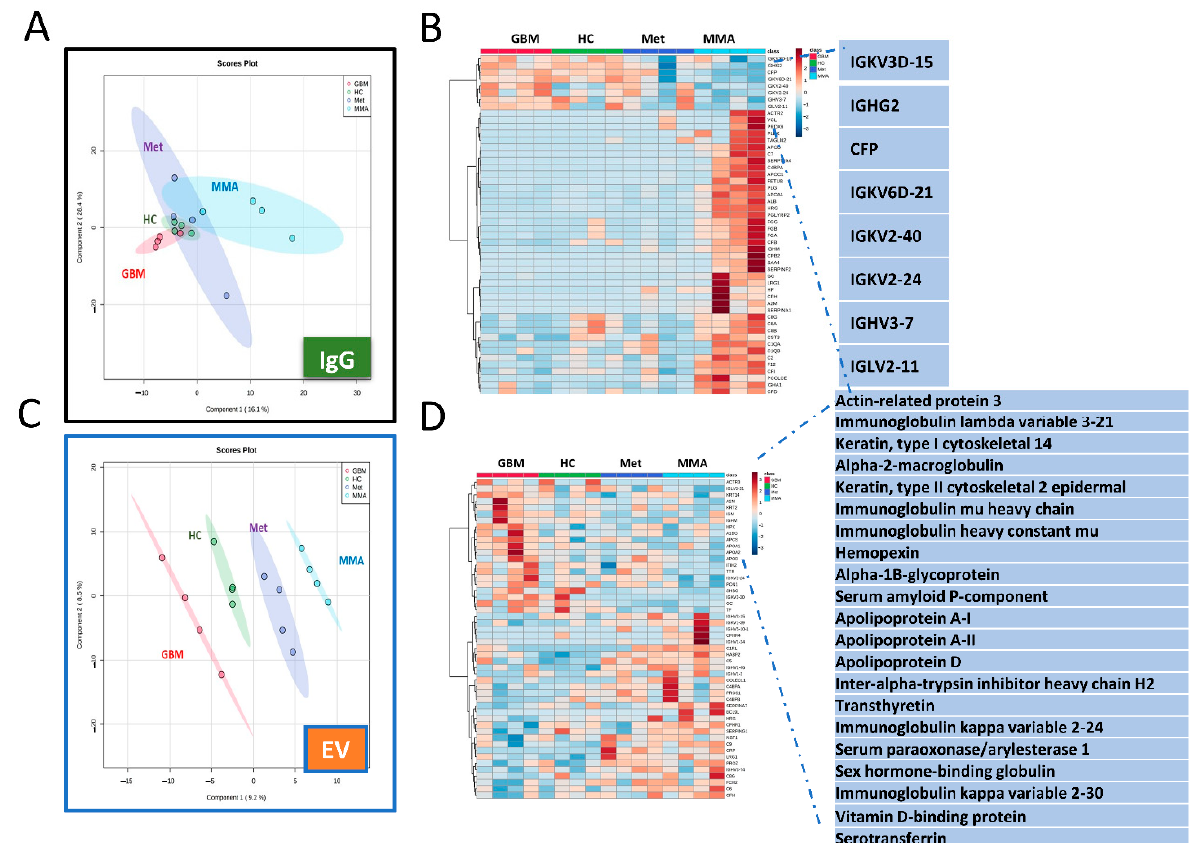
Figure 5. Mass spectrometry proteomic analysis of EVs and purified IgG antibodies showing unique clusters of proteins in GBM. ( A , B ). Proteomic analysis for IgG antibodies. ( A ). Principal Component Analysis (PCA) showed distinctions among the four groups of samples including GBM, MMA, metastatic brain tumors (Met), and HC. ( B ). Heat map of total IgG proteomics showing the top 50 proteins in each group. The upregulated IgG antibodies in GBM, HC, and Met compared to MMA are highlighted. ( C , D ). Proteomic analysis of plasma EVs demonstrated the unique proteins in GBM EVs. ( C ). PCA shows clear clusters of proteins in each EV group. ( D ). Heat map showing unique proteins detected in GBM EVs including immunoglobulin heavy and light chains and apolipoproteins. In the Supplementary Files, Volcano plots for comparing up- and down-regulated proteins in GBM and HC purified IgG and EV samples are presented in Figures S1 and